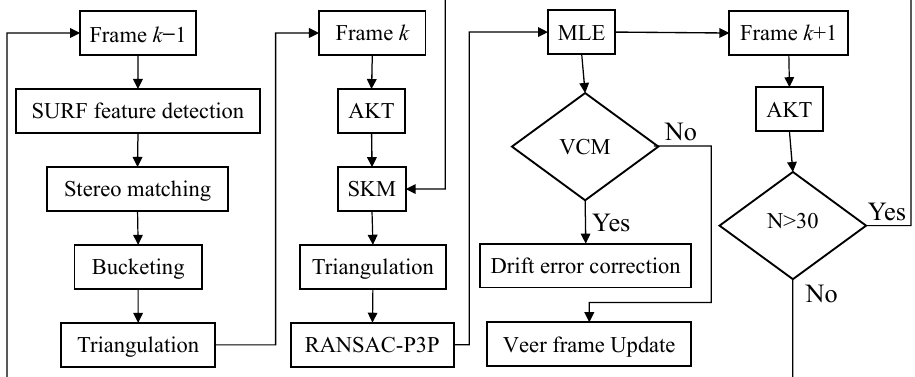
Figure 1. Flowchart of the proposed approach.